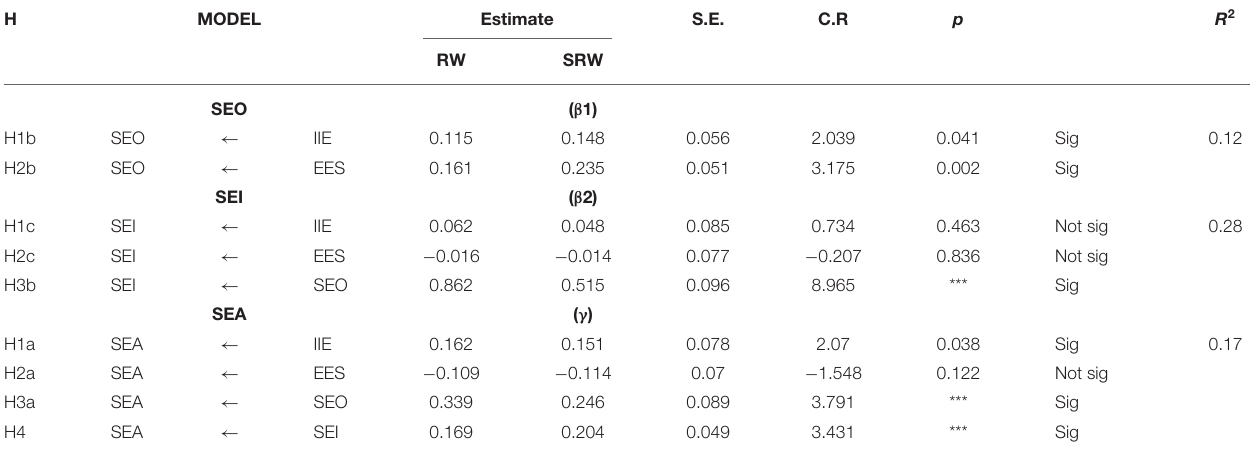
TABLE 12 | Summary of estimation results for structural model parameters. H